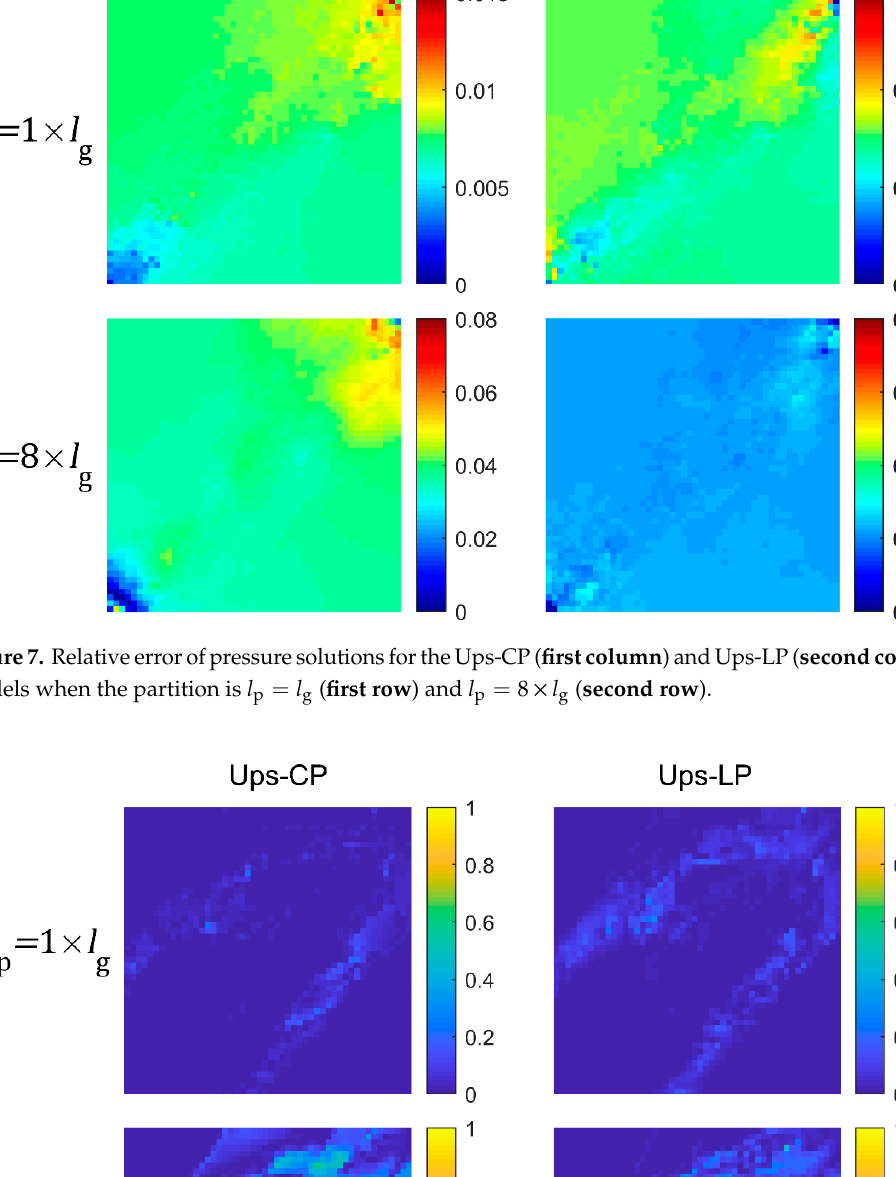
Figure 9. Tracer concentration at the outlet as a function of pore-volume injected for full model, Ups-CP, and Ups-LP for (cid:1864) p = (cid:1864) g ( left ) and (cid:1864) p = 8 × (cid:1864) g ( right ).